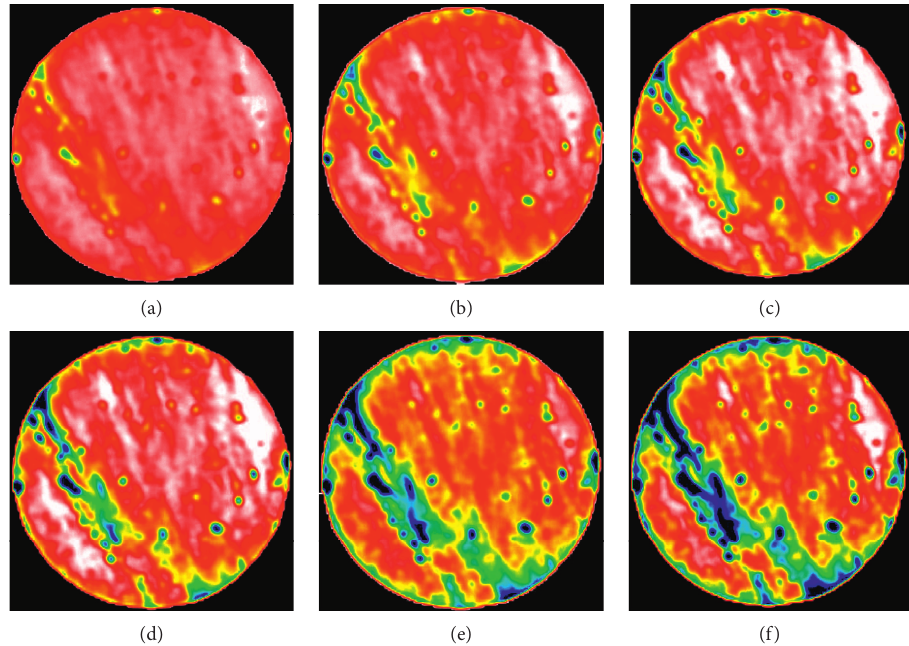
Figure 8: Pseudo-color-enhancement of CT images of the 10 th slice of sample M1 after freeze-thaw cycles. (a) 0 cycles. (b) 20 cycles. (c) 40 cycles. (d) 60 cycles. (e) 80 cycles. (f) 100 cycles.